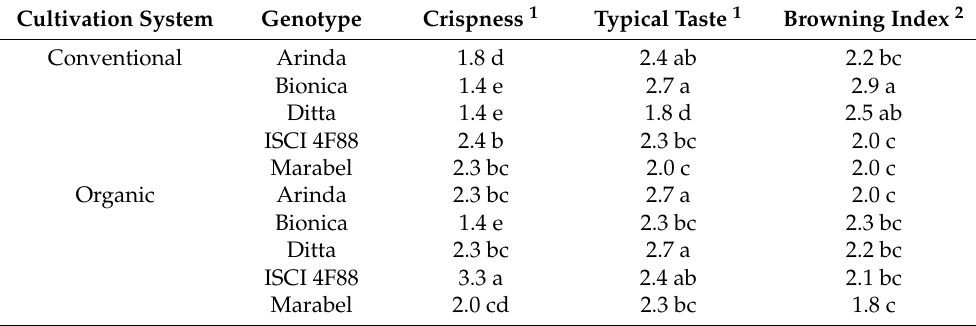
Table 8. Sensory traits after frying of early potatoes as affected by ‘cultivation system × genotype’